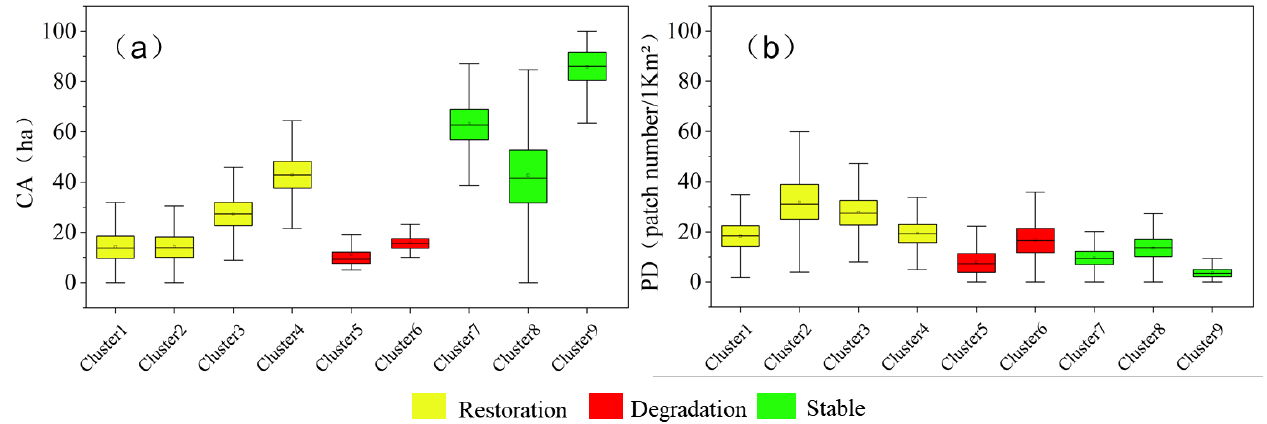
Figure 3. Distribution of forest landscape indices in different clusters: ( a ) forest cover area (CA) and ( b ) patch density (PD).